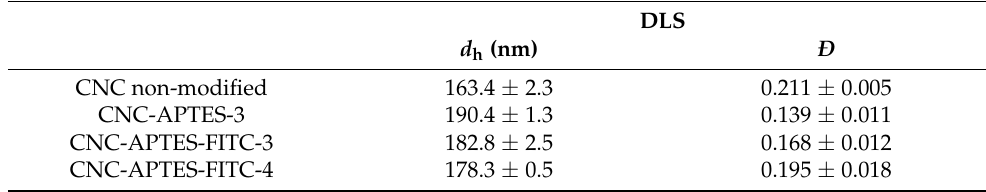
Table 3. d h and Ð determined by